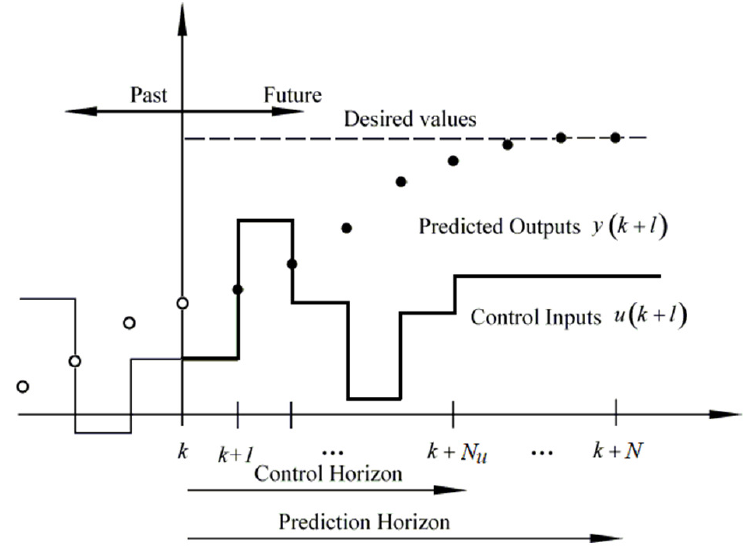
Figure 24. Principle of MPC